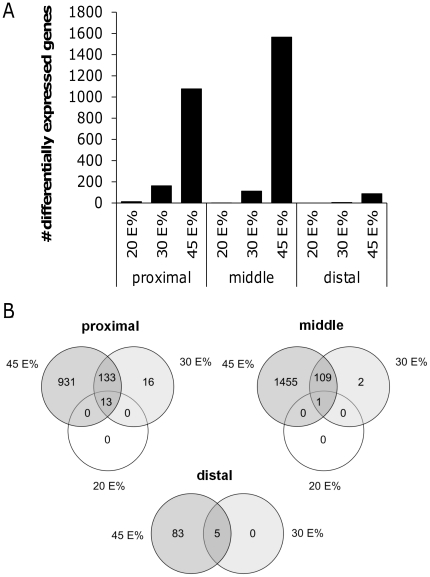
Differential gene expression along the longitudinal axis of the small intestine.For the proximal, middle and distal part of the small intestine, the numbers of genes that are differentially expressed on a 20E%, 30E% and 45E% fat diet compared to the control 10E% fat diet are plotted (A). Venn diagrams display the overlap of differentially expressed genes between the 20E%, 30E% and 45E% fat diets for each part of the small intestine (B).